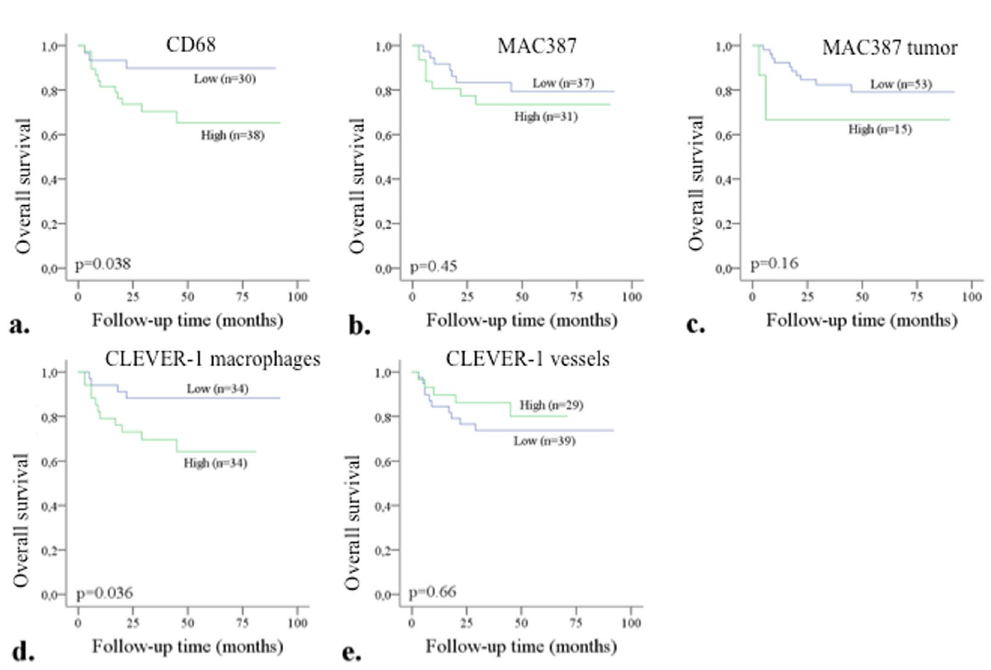
Figure 4. Kaplan-Meier estimates for OS after NAC treatment. The effect of CD68 + ( a ), MAC387 + macrophages ( b ), MAC387 + tumor cells ( c ), CLEVER-1 + macrophages ( d ) and CLEVER-1 + vessels on